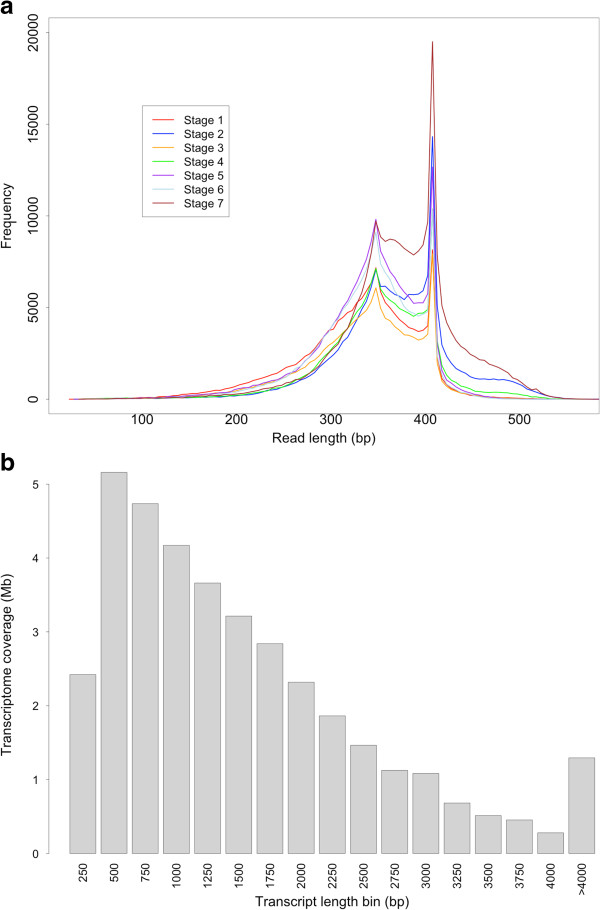
Filtered reads and assembled transcript length distributions. (a) Distribution of sequence read lengths used in transcriptome assembly from each of the seven developmental stages after quality filtering and trimming. (b) Histogram of assembled transcripts binned at 300 bp intervals and the relative contribution of each bin to the overall transcriptome size.